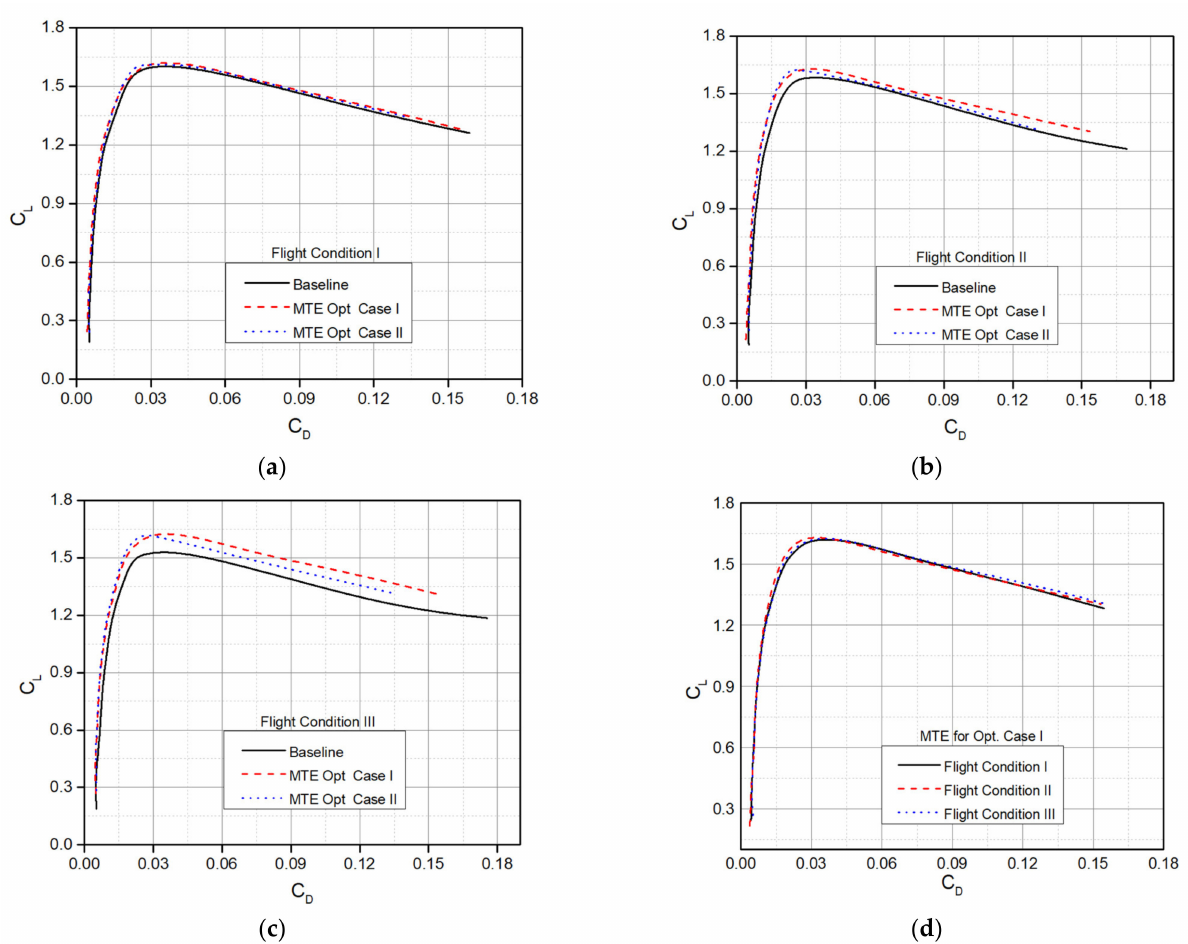
Figure 21. Lift coefficients versus drag coefficients for various optimized design configurations. ( a ) the drag polar at Flight Condition I; ( b ) drag polar at Flight Condition II; ( c ) drag polar at Flight Condition III; ( d ) drag polar for all three flight conditions for Opt. Case I.